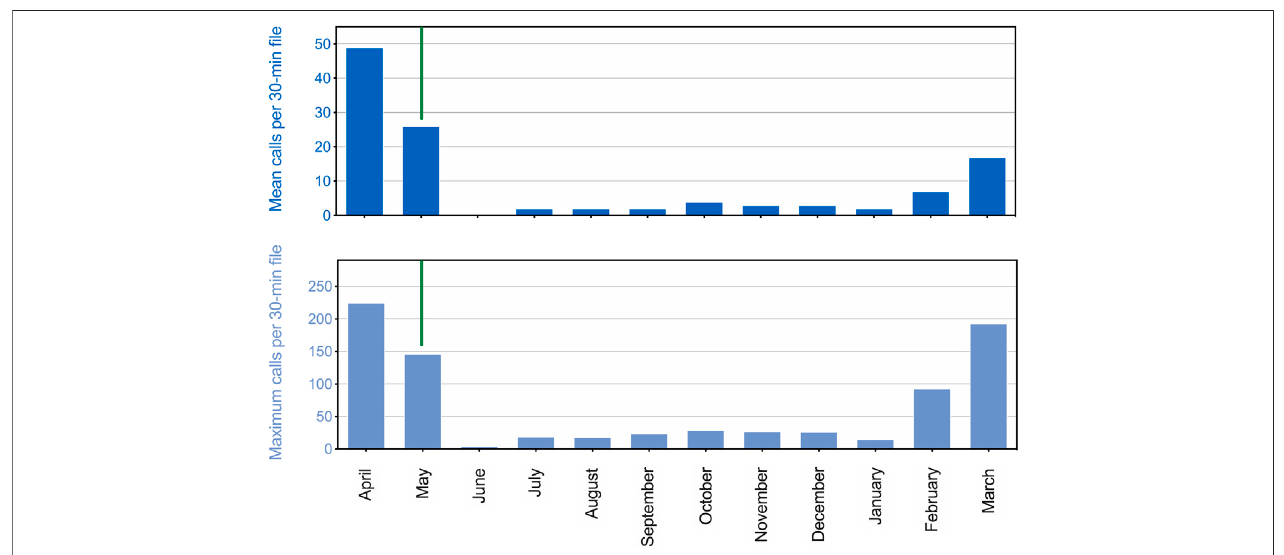
FIGURE 3 | Seasonal patterns in call production for two adult male spotted seals. The mean number of calls per 30-min fi le is shown for a 12-month period (April 2017 through March 2018) in the upper panel. The maximum number of calls per 30-min fi le per day was also averaged over each month, and is shown in the lower panel. A vertical green line separates the end of the suspected breeding season (left) from the onset of the molting period (right), which began on 15 May 2017.